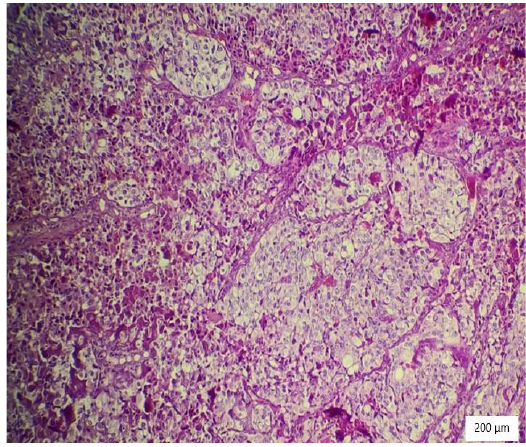
Figure 2. Solid architecture of the tumor with highly atypical cells with hyperchromatic nuclei and necrosis (HE ×100).